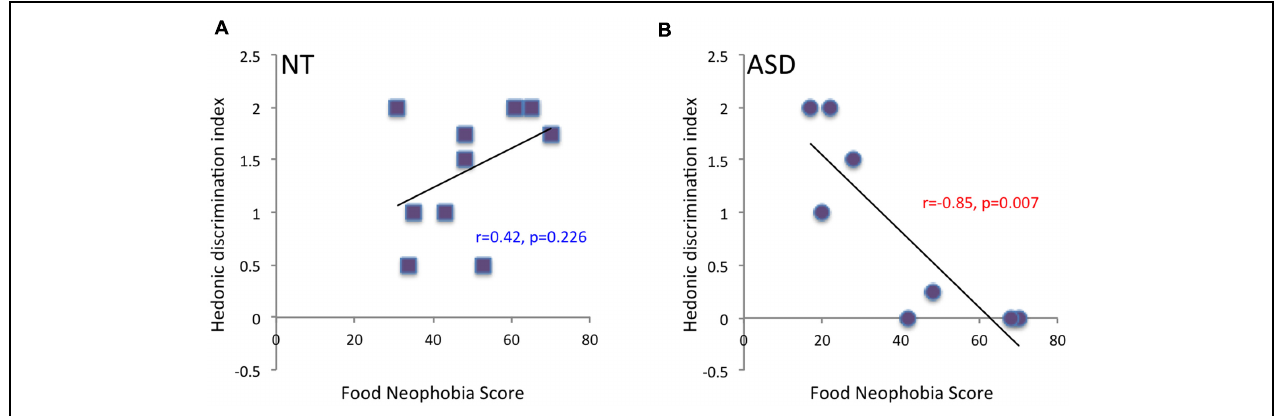
FIGURE 5 | Correlation between hedonic categorization index and food neophobia score. A significant negative correlation between odor hedonic categorization index and food neophobia score was observed in ASD children ( p = 0.006) (B) , but not in NT children (A) .